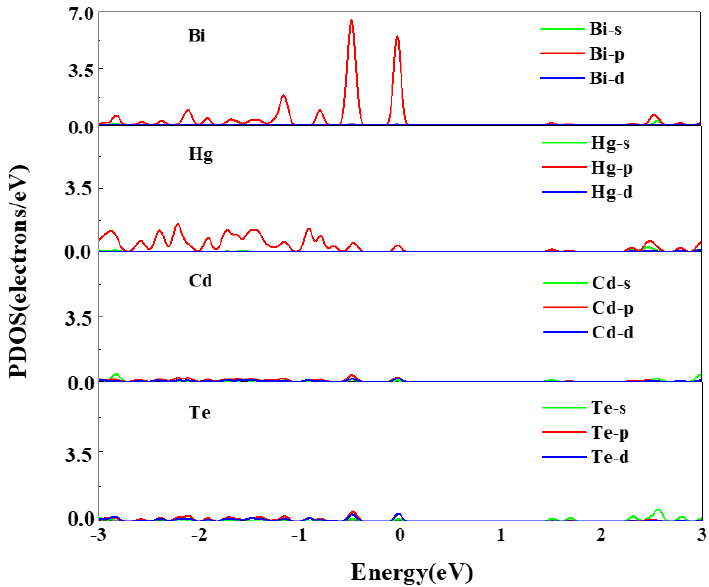
Figure 5. Partial DOSs of Bi, Hg, Cd, and Te in Bi Te -doped Hg 0.75 Cd 0.25 Te.